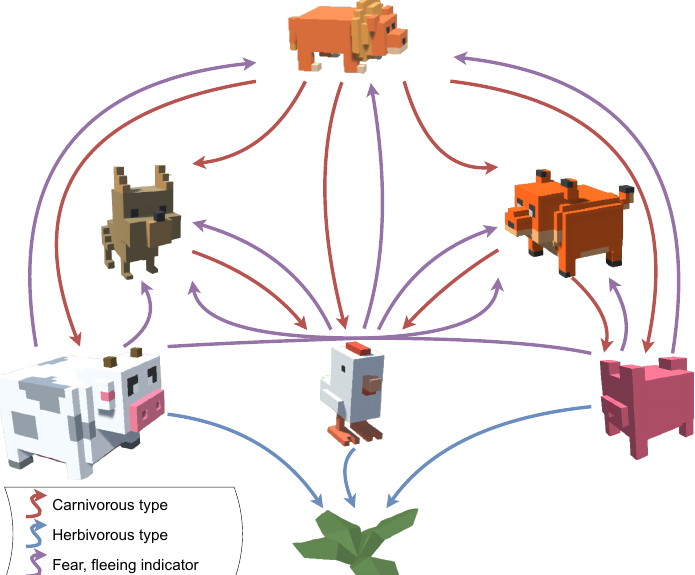
Figure 3. A sample food-chain relation with different types of species which was used in our previous article. The living entities are organized into chain-levels.